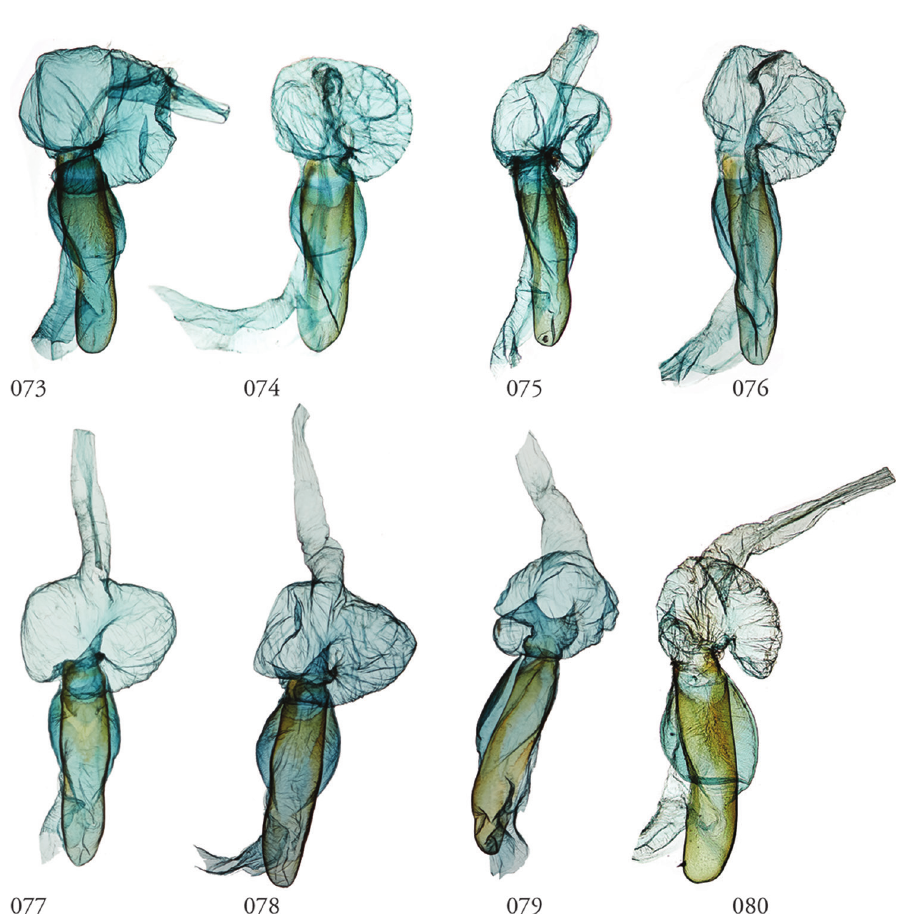
Figs 41–48; Male genitalia: Figs 70, 80; Female genitalia: Fig. 87 Iheringia santista Jones, (1915) 1914 Type locality: Brazil. Material examined. Type material (2 ♂ ). SYNTYPES: [Brazil] Type, Iheringia